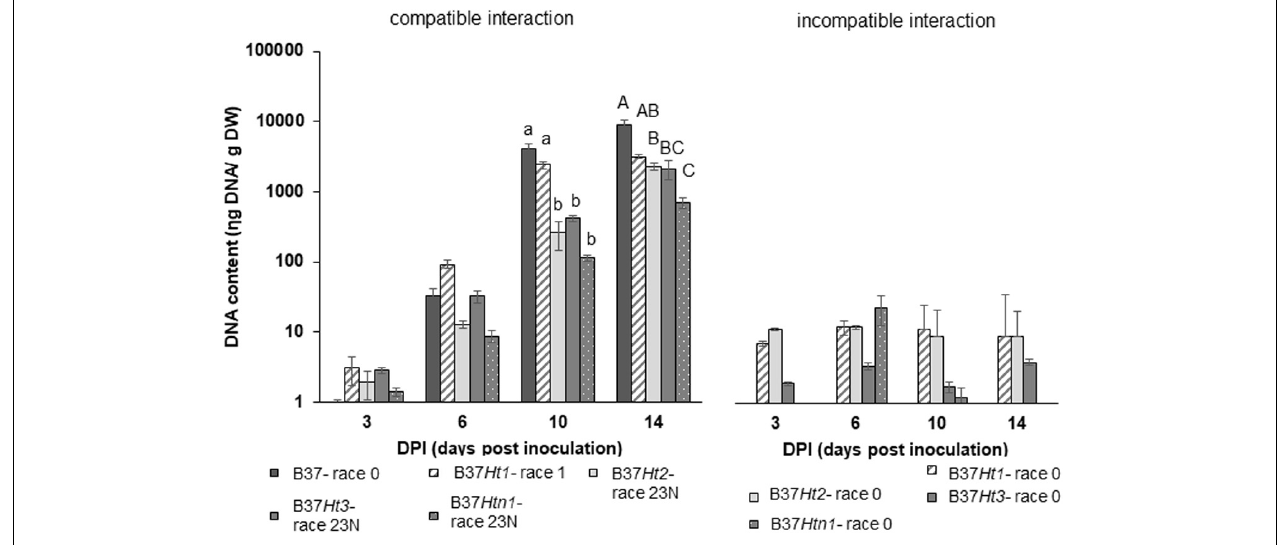
FIGURE 4 | DNA-contents with standard errors for compatible and incompatible interactions between Exserohilum turcicum and the maize lines B37 without resistance genes and with the resistance genes Ht1 , Ht2 , Ht3, and Htn1 . Samples for qPCR analysis were collected 0, 3, 6 10, and 14 days post inoculation (dpi). The DNA content is presented in η g DNA/g leaf dry weight. The fourth and fifth leaves from three plants were pooled in one biological replicate. In total, nine plants were harvest per treatment and timepoint ( n = 3 biological replicates). Data from the first replication experiment are presented in the graph. Lowercase letters indicate significant differences between treatments at 10 dpi. Uppercase letters indicate significant differences between treatments at 14 dpi. Means sharing the same letter were not significantly different following Tukey-adjusted comparisons for data with a log-transformation ( p ≤